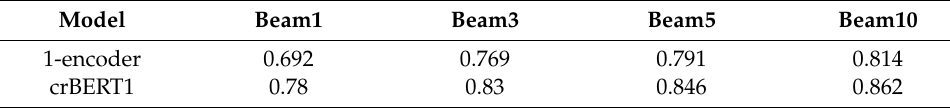
Table 4. BLEU experiment results for task 5.